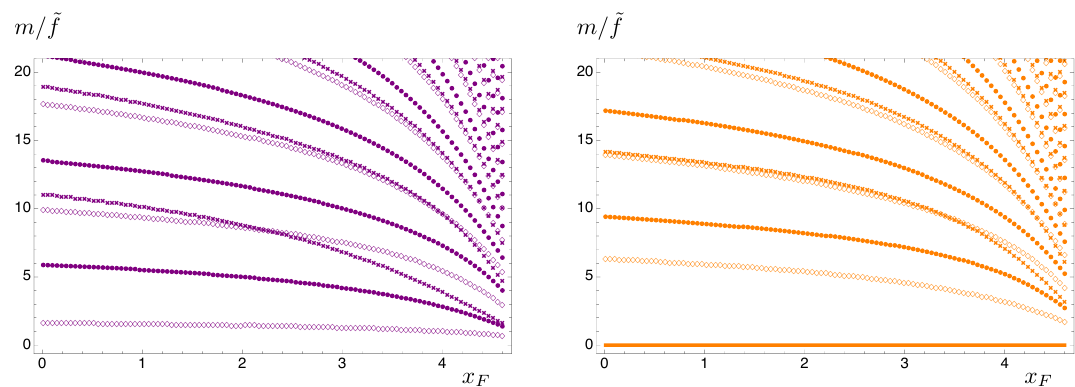
Figure 2 . Model I. Fermionic spectrum as a function of ∆ R for x F = 0 . 5 , 2 , 4 (diamonds, dots, crosses), ∆ = 2 . 5 , g 5 = 8 , r 1 = 10 − 12 , r 2 = 15 . The left and right panels correspond to imposing (+) and ( − ) IR boundary conditions, respectively. All plots are normalised to the decay constant ˜ f (notice that Λ IR / ˜ f ’ 2 . 4 , 2 . 1 , 1 . 3 for x F = 0 . 5 , 2 , 4 ). The solid line in the right panel indicates the presence of a massless state.